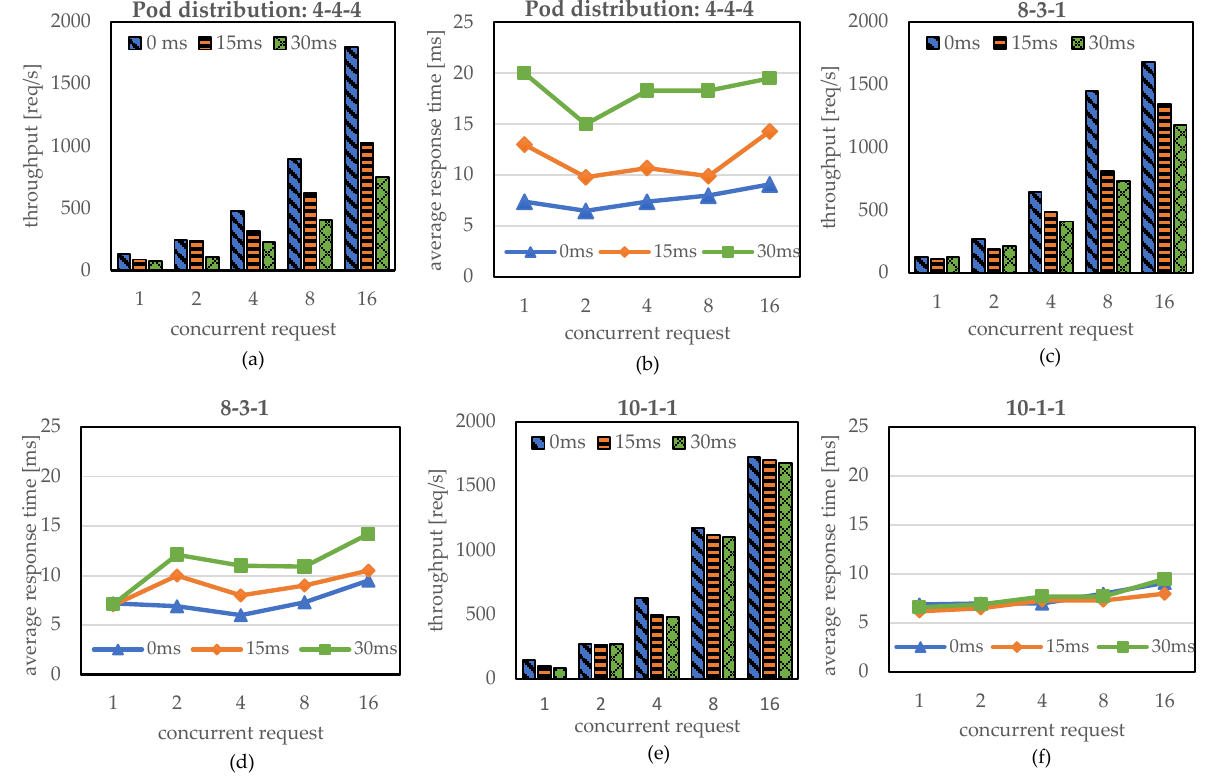
Figure 6. Throughput and average response time according to pod distribution and delay between edge nodes ( a , d ): 4-4-4, ( b , e ): 8-3-1, ( c , f ): 10-1-1. However, both the throughput and the average response time are highly affected by the pod distribution as the delay between edge nodes increases. For example, when the delay is 30 ms, the pod distributions 4-4-4, 8-3-1, and 10-1-1 show about 755 req/s, 1180 req/s, and 1682 req/s, respectively, for 16 concurrent requests. This indicates that the throughput degrades proportionally to the amount of traffic forwarded to the edge nodes. In other words, 2 out of 12 requests in the 10-1-1 pod distribution are forwarded to the remote edge nodes, whereas 8 out of 12 requests in the 4-4-4 pod distribution are handled by remote edge nodes. Therefore, more than 50% of the throughput was degraded in the